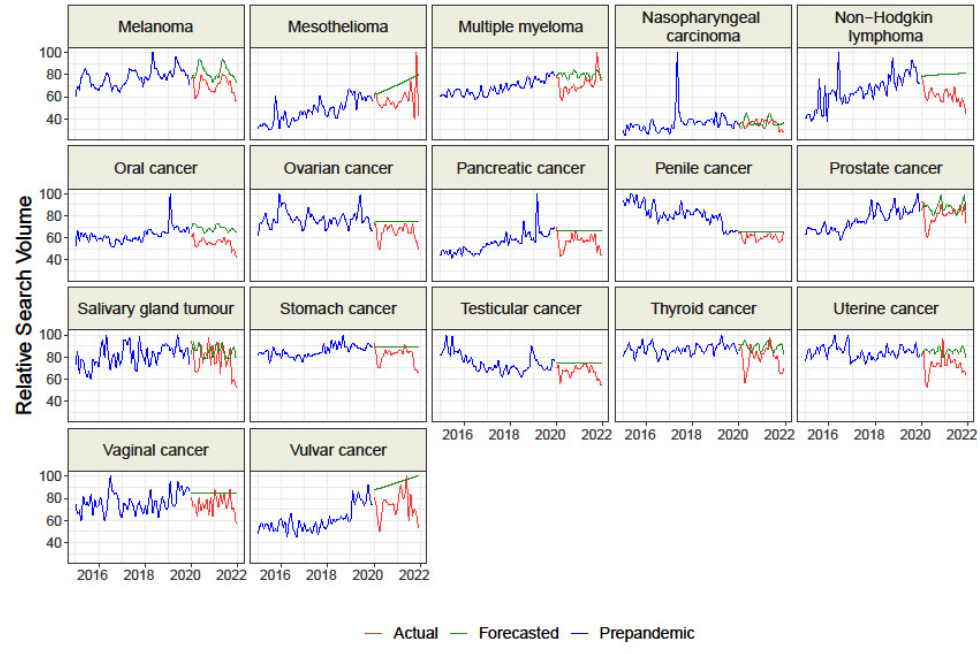
Figure 3. Relative Search Volume of Google queries on chosen malignancies.